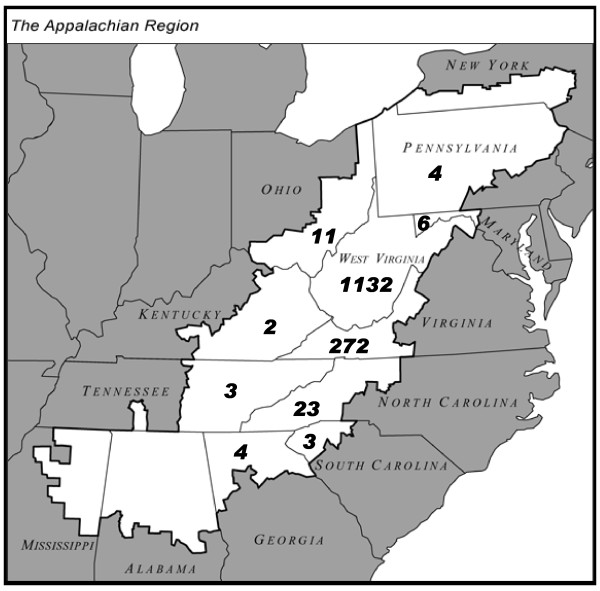
The Appalachian region. The Appalachian Region as defined by the Appalachian Regional Commission is highlighted in white. The numbers in each Appalachian state represent the number of Appalachian participants from that state who participated in the survey.